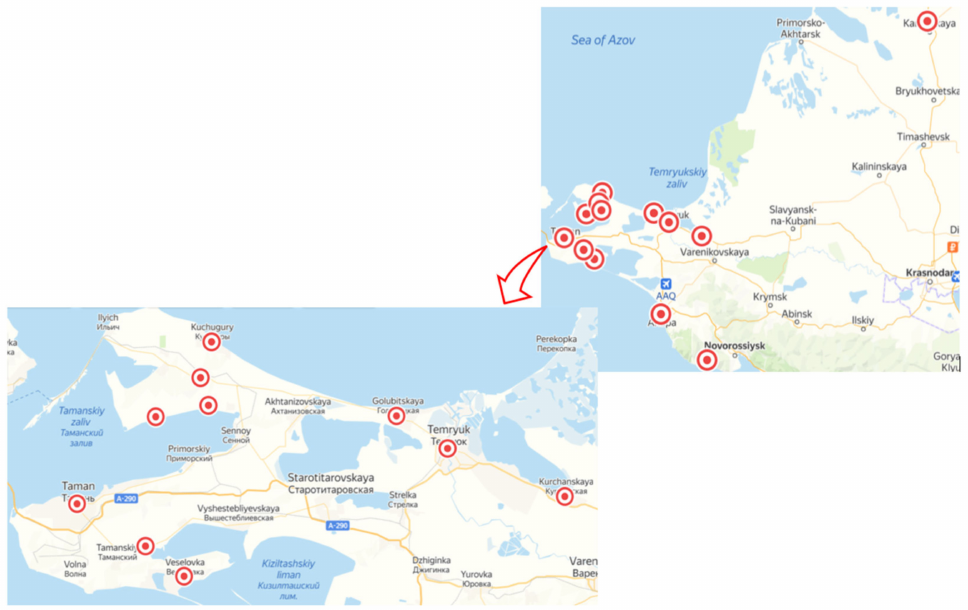
Figure 2. Locations of selected vineyards in Krasnodar Krai in